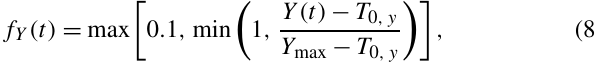
of parameters is presented and predictions of Eq. (4) com- pared against a common gas-exchange model in Sect.